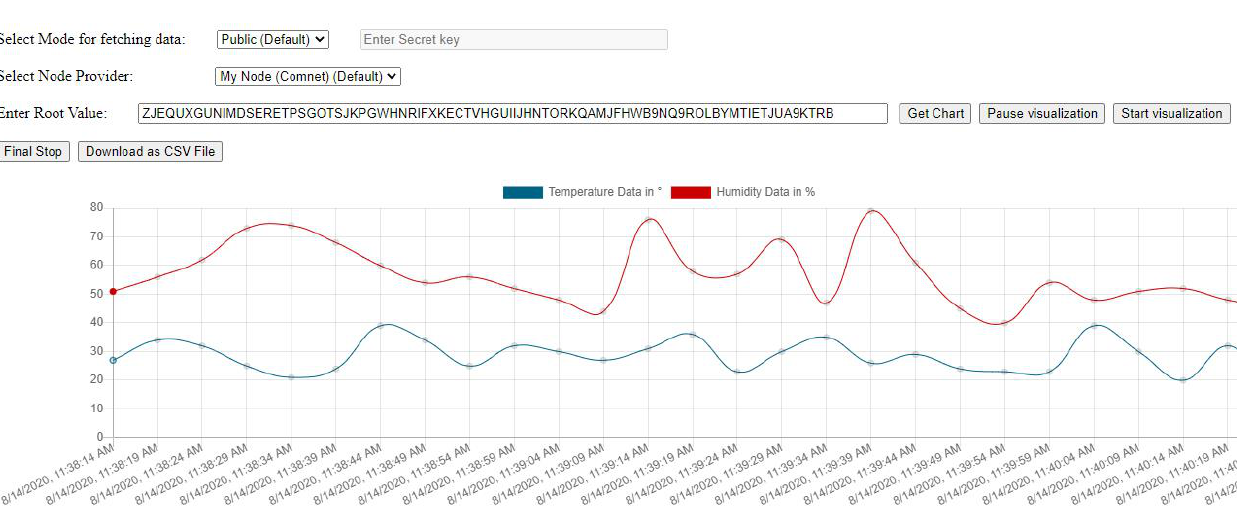
Figure 14. IoT sensor data visualizer app.